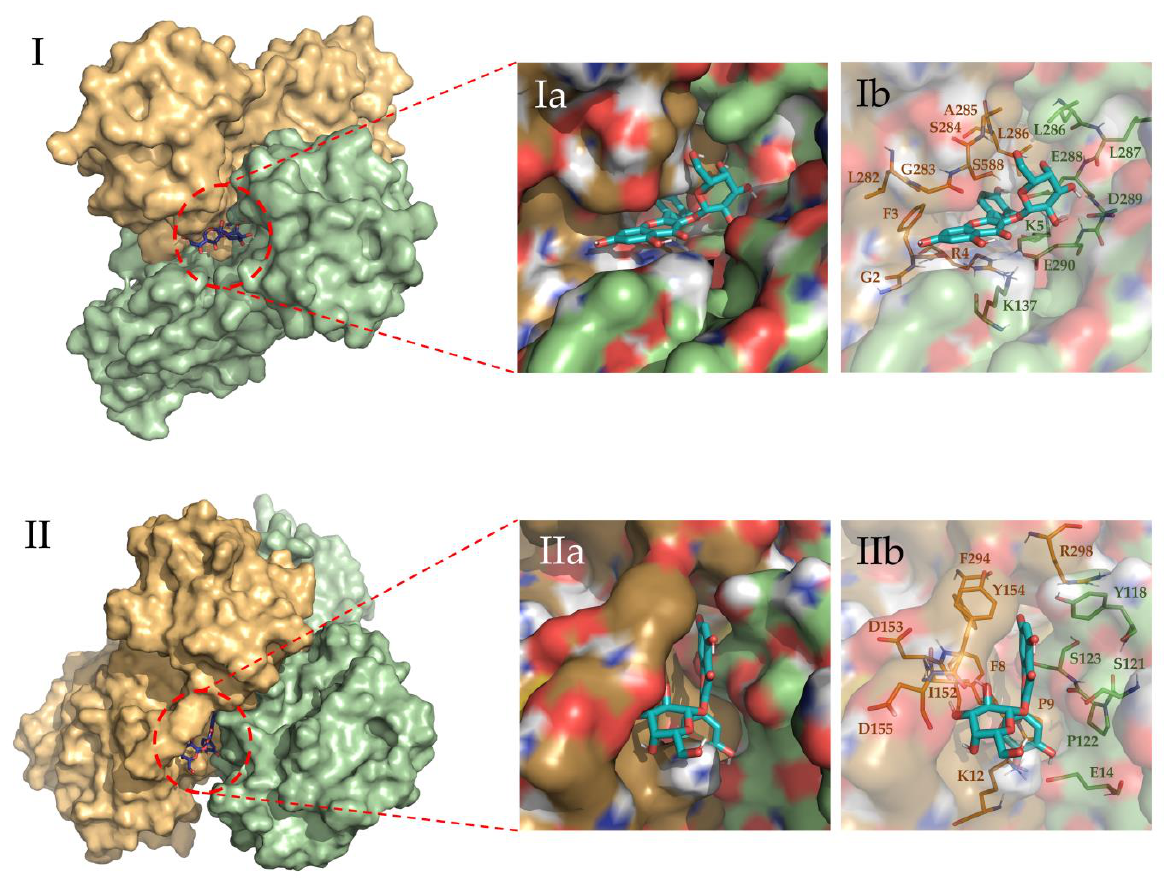
Figure 5. Binding site representation of the selected complexes for Hyperoside, at the last snapshot of their 2 µ s molecular dynamic simulations. The two monomers of the M pro SARS-CoV-2 main protease dimer are depicted in light green (Chain A) and light orange (Chain B). Allosteric interactions depicted correspond to the first ( I ) and second ( II ) most stable binding sites identified for Hyperoside, with binding energies of − 60.1 kcal/mol and − 53.3 kcal/mol, respectively. ( Ia ) and ( Ib ) representations show the ligand bound to the ligand pocket, and ( IIa ) and ( IIb ) representations depict the spatial distribution of the residues defining the interacting pocket.